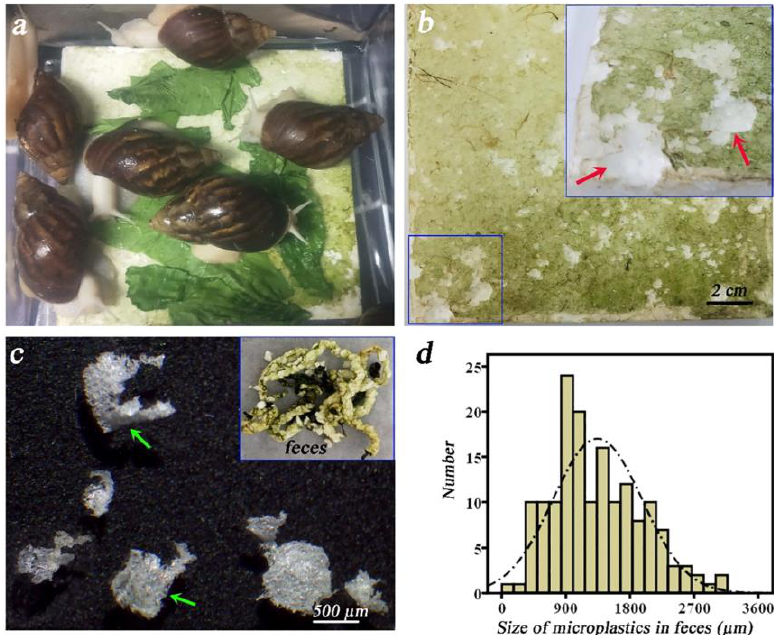
Figure 11. PS foam were uptaken by A. fulica and fragmented into microplastics. ( a ) The exposure scene of Styrofoam and A. fulica . ( b ) Mark of gnawing on Styrofoam (the top right showing enlarged image in the blue box). ( c ) Microplastics in feces. ( d ) The distribution of microplastic sizes, reprinted with permission from [59].